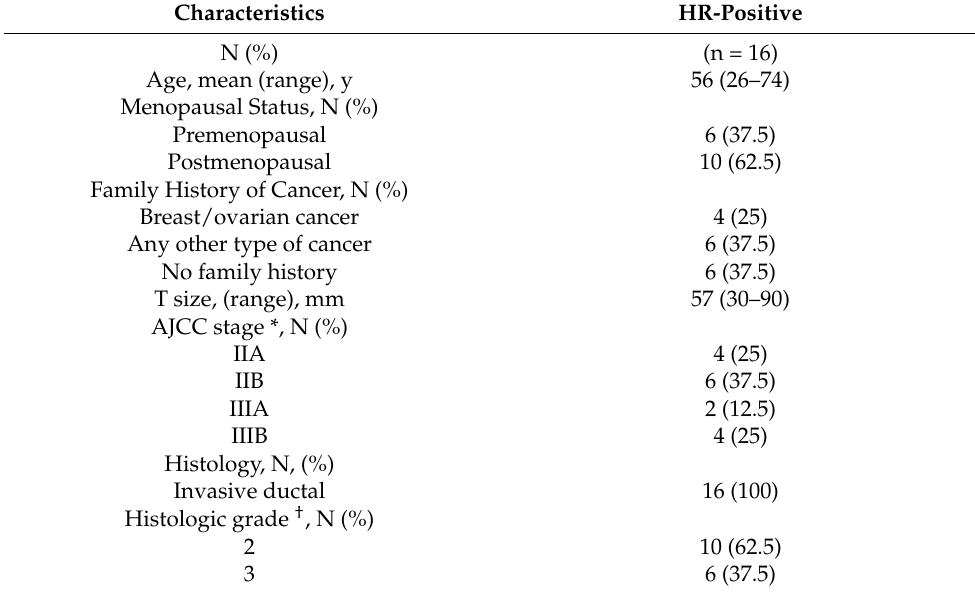
Table 2. Patient and tumor characteristics at